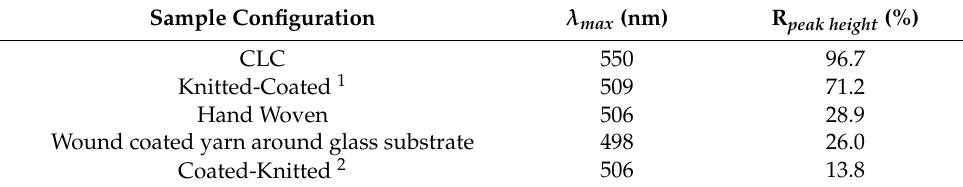
Table 2. Quantitative comparison of the color density of fabric swatches from peak values at λ max . Sample